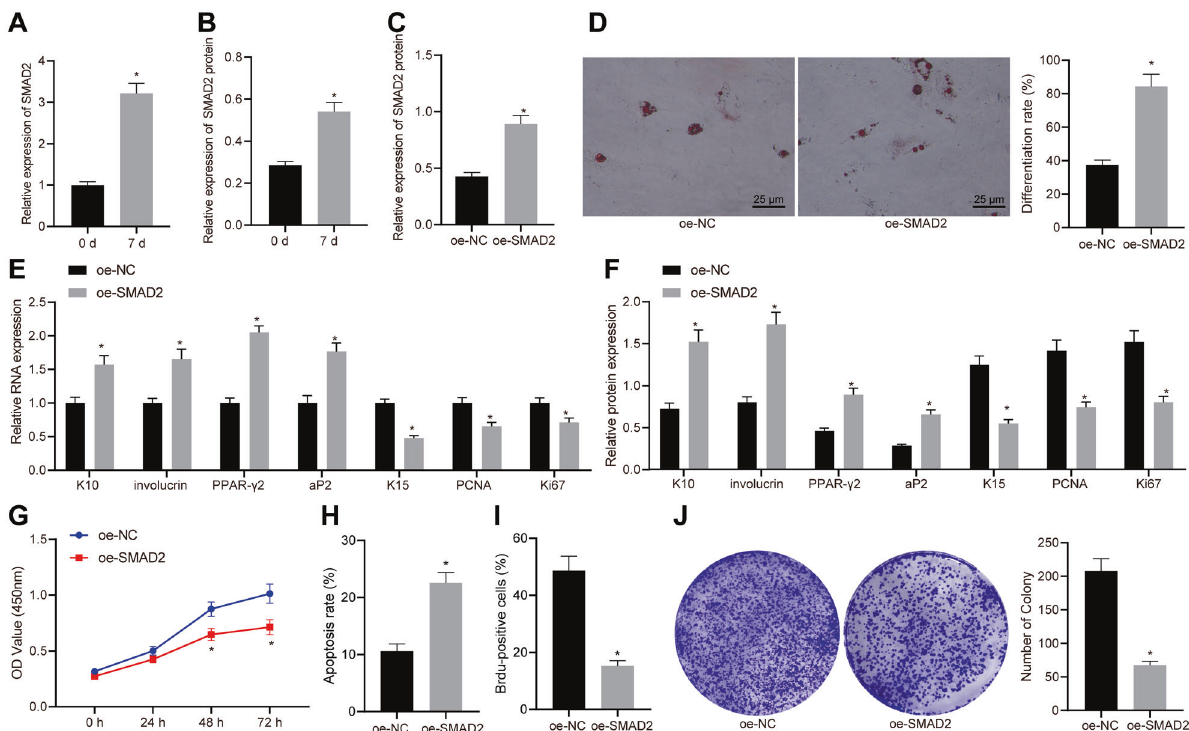
Fig. 1 SMAD2 is upregulated in HFSCs after differentiation and its overexpression promotes the differentiation of HFSCs but suppresses cell proliferation. SMAD2 mRNA ( A ) and protein ( B ) levels in HFSCs after 7-day induction of cell differentiation measured by RT-qPCR and western blot assay, with β -actin as internal reference, * p < 0.05 vs. day 0. C SMAD2 protein level in HFSCs transduced with lentivirus-packaged oe-SMAD2. D Cell differentiation determined by oil red O staining (×400). mRNA ( E ) and protein ( F ) levels of epidermal differentiation markers (K10 and involucrin), adipogenesis markers (PPAR- γ 2 and aP2), keratinocyte-speci fi c marker (K15), and proliferation-related markers (PCNA and Ki67) in HFSCs overexpressing SMAD2 measured by RT-qPCR and western blot assay, with β -actin as internal reference. G Cell viability in HFSCs in response to SMAD2 overexpression determined by CCK-8 assay. H Apoptosis of HFSCs in response to SMAD2 overexpression determined by fl ow cytometry. I Proliferation of HFSCs in response to SMAD2 overexpression assessed by BrdU labeling. J The number of colonies formed in HFSCs in response to SMAD2 overexpression. * p < 0.05 vs. oe-NC group. Data are expressed as mean ± standard deviation. Data comparison between two groups was performed by unpaired t test, while data between multiple groups were compared by one-way ANOVA with Tukey ’